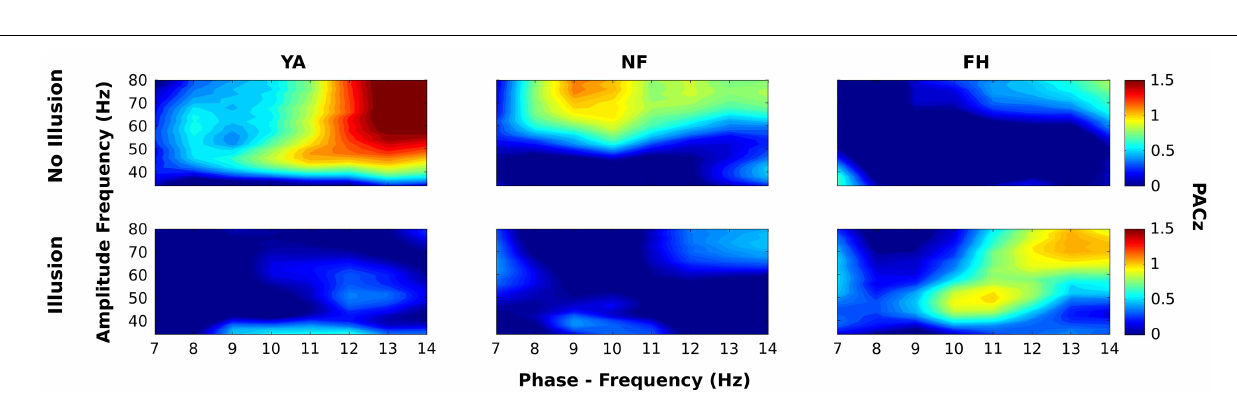
uncorrected p = 0.61) or between age and (cid:52) alpha ( r =